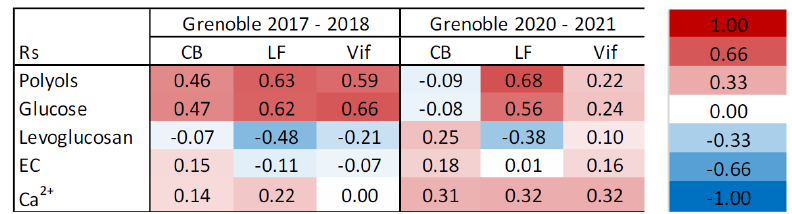
Table 7. Spearman correlations ( R s ) between cellulose and characteristic chemical tracers at the Grenoble-based sites, across the two separate sampling periods: 2017–2018 and 2020–2021. A red cell indicates a positive correlation between cellulose and the selected chemical tracer, whilst a blue cell indicates a negative correlation. A colour-coded key of corresponding R s values is to the right of the table. Site classifications are as follows: urban for Caserne de Bonne (CB), urban background for Les Frênes (LF), and peri-urban for Vif. Note that polyols row represents the sum of arabitol, mannitol, and sorbitol.